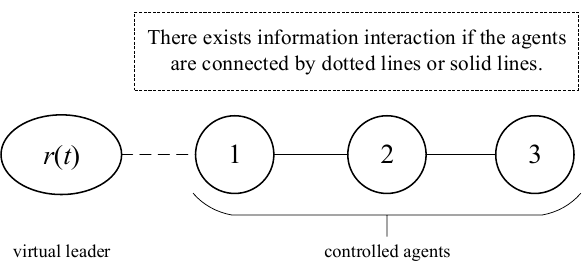
virtual leader controlled agents Figure 1. Communication graph of multi-agent Figure 1. Communication graph of multi-agent system.